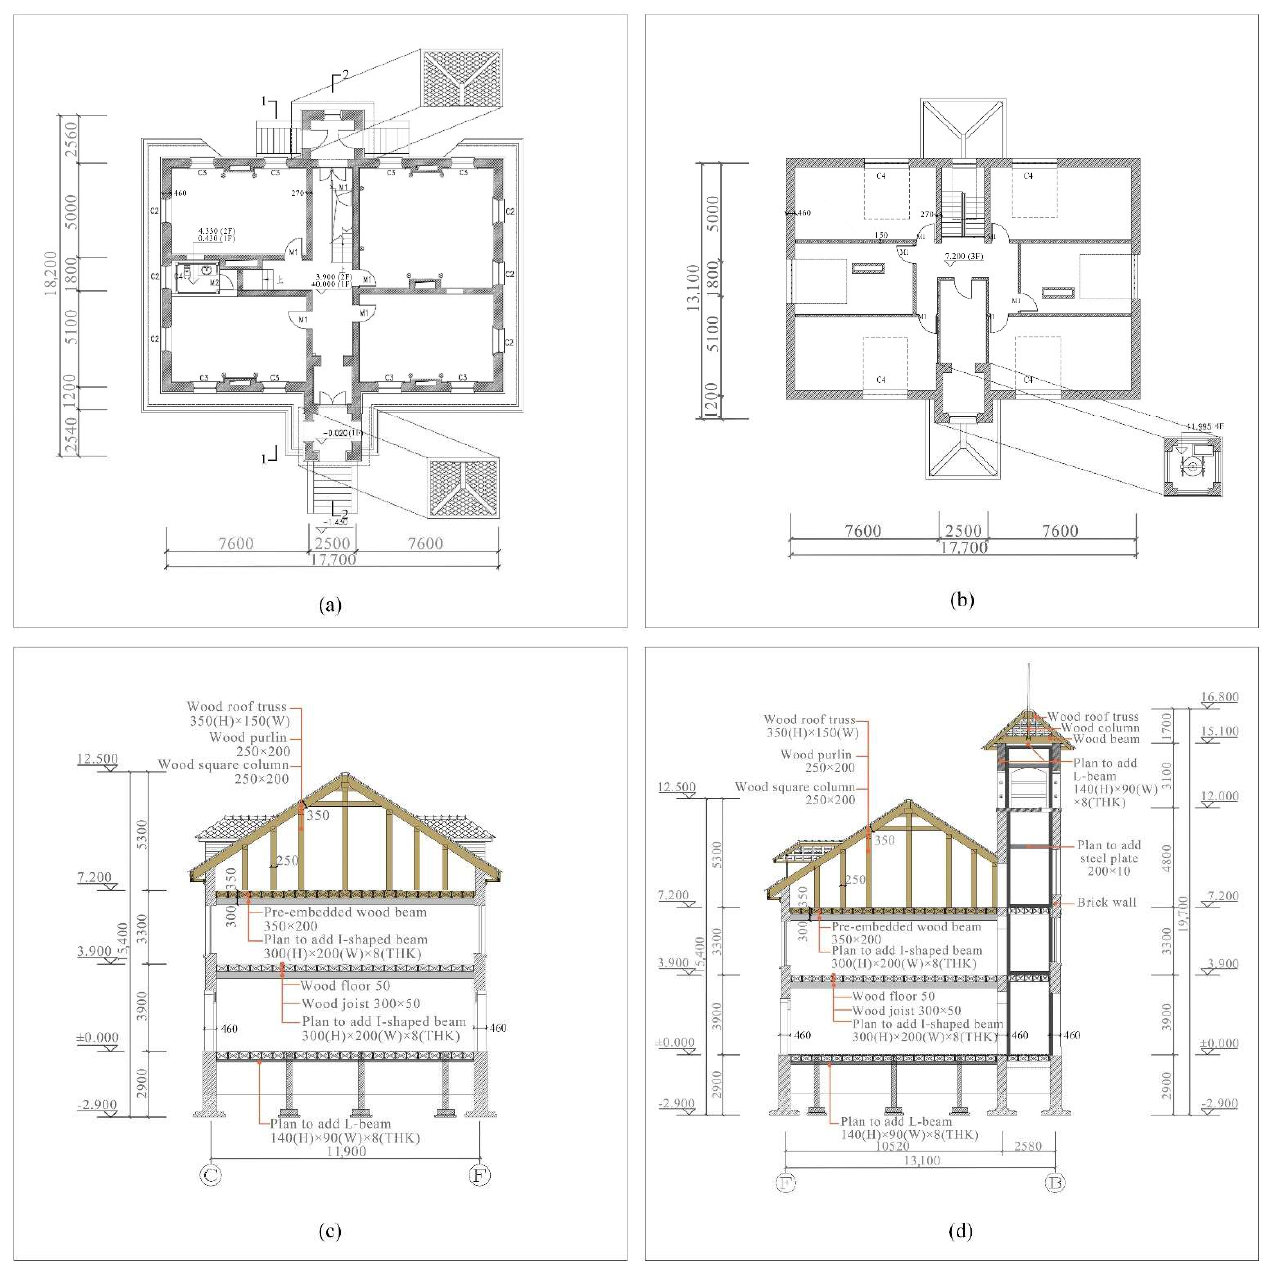
Figure 10. Structural elements of the bell tower (source: author). ( a ) The first and second floor plan ( b ) The third floor plan. ( c ) Building structure element (1 − 1 section diagram) ( d ) Building structure clement (2 − 2 section diagram).